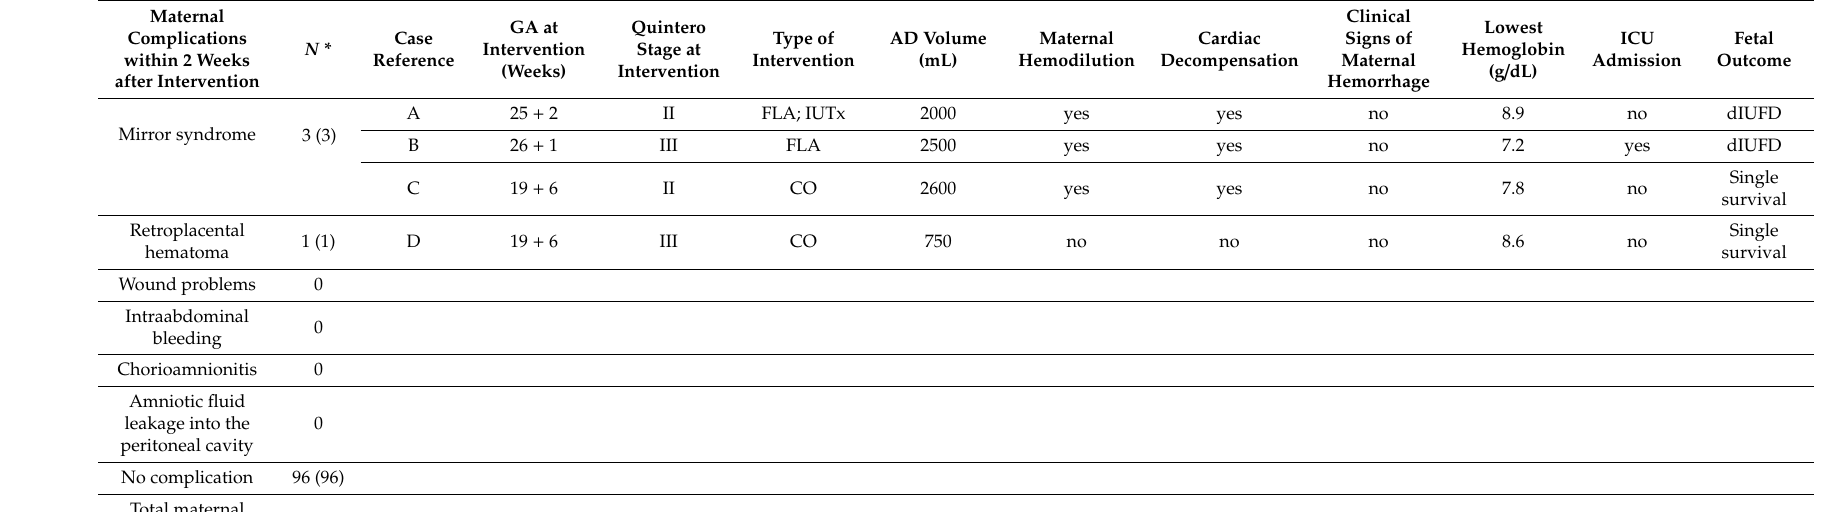
Table 3. Maternal complications related to intrauterine surgery within 2 weeks after the